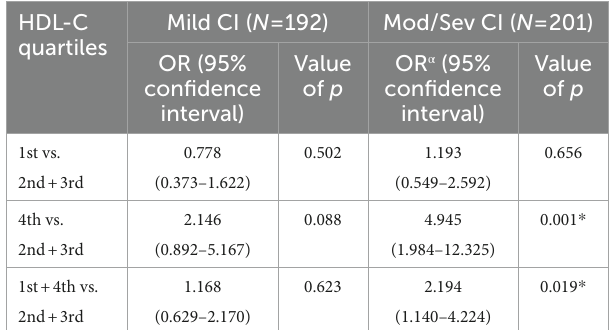
TABLE 4 Prevalence of cognitive impairment in various HDL-C quartiles. TABLE 5 Logistic regression showing the risk of cognitive impairment in the lowest and the highest quartiles of HDL-C (with middle quartiles as the reference) among